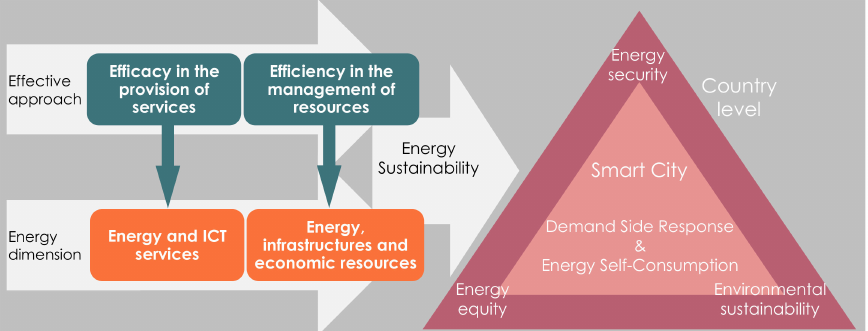
Figure 7. E ff ectiveness of the energy dimension of smart cities to achieve energy sustainability in urban areas and